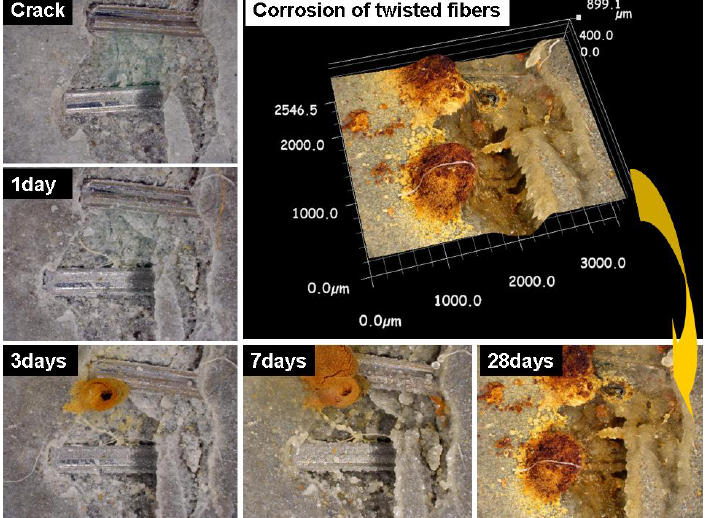
Figure 14. Corrosion process of T-fibers in exposed cracked area with crack width >200